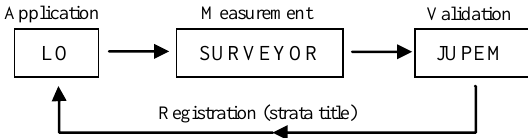
Figure 1. Standard flow for strata title registration